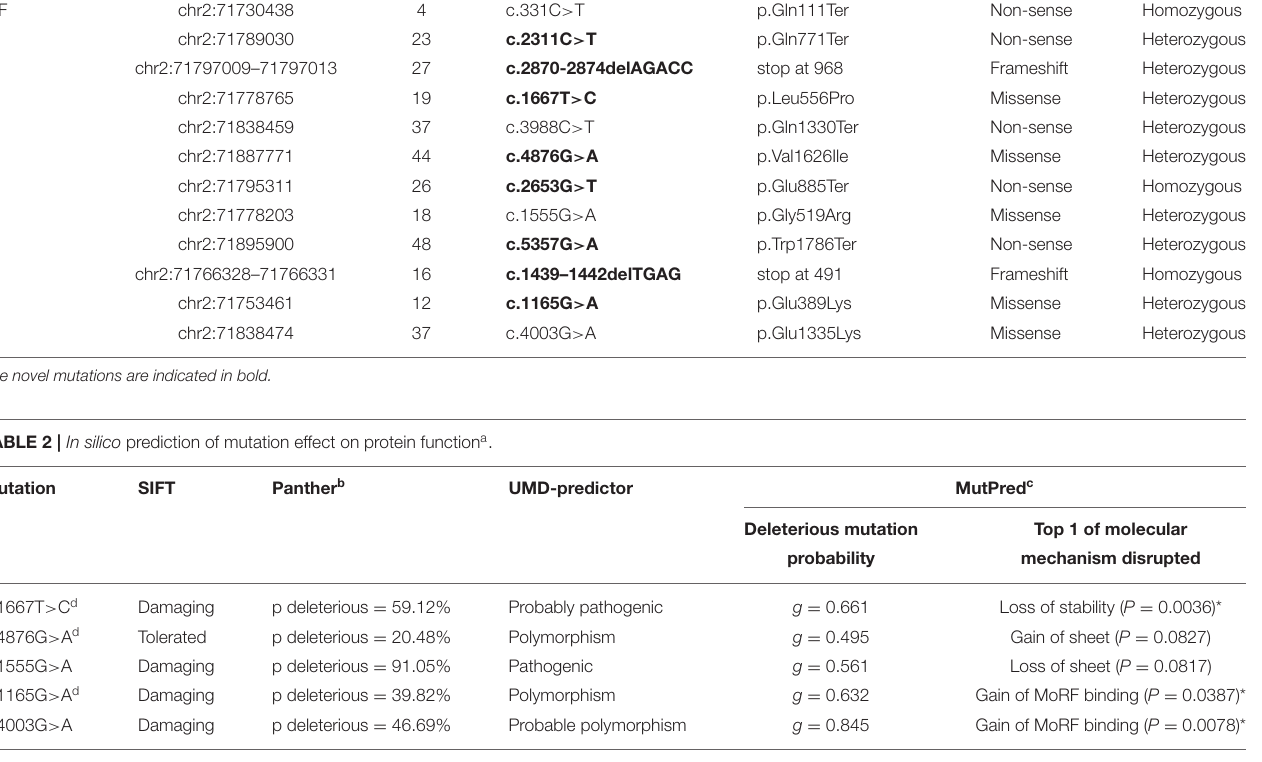
TABLE 1 | Summary of mutations identified in eight patients with dysferlinopathy. Patient no.